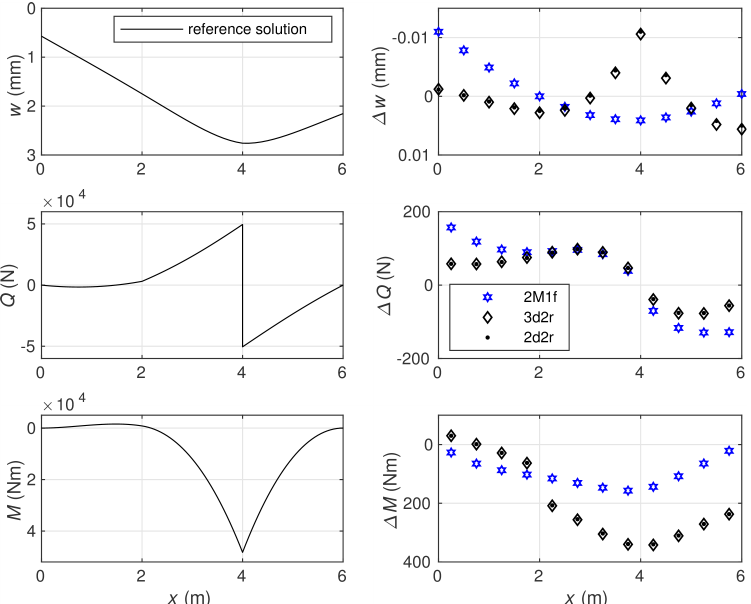
Figure 11. The reference solution: the deflection, shear force, and bending moment ( left diagrams ); comparison of these quantities obtained with 12 element meshes with the reference solution: for 2M1f, 3d2r, and 2d2r models ( right diagrams ). K s = 1.0714 · 10 9